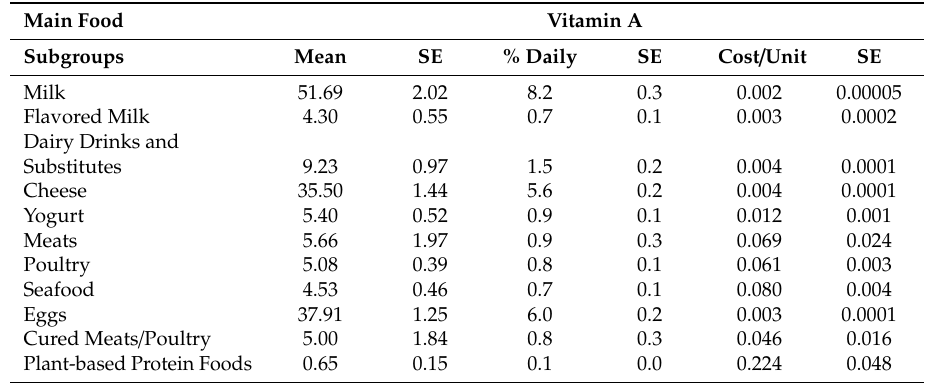
Table 14. Percent daily vitamin A (RAE mcg) and cost ($) of vitamin A from eggs in adults, compared to USDA protein food